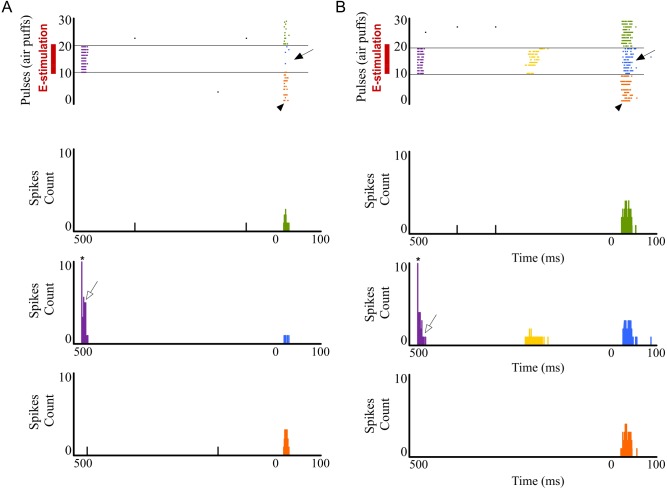
POm E-stimulation before whisker stimulus does not decrease cortical response magnitude and duration when PTX is applied in L1.Raster plots and PSTHs are shown for a supragranular neuron before (A) and after (B) GABAergic inhibitory inactivation in L1. Before PTX application, sensory response (filled arrows) of this example neuron was abolished by POm E-stimulation before whisker stimulus. However, POm E-stimulation did not reduce sensory response when GABAergic inhibitory transmission in L1 was inactivated (B). GABAergic inactivation in L1 allowed POm E-stimulation to cause rebound spikes (in yellow). PTX effect is also shown in the sensory response (arrowheads) enlargement after PTX application. Control condition before (orange) and after (green) POm E-stimulation condition (blue) are shown. POm E-stimulation was applied 500 ms before pulses (air puffs) 11 to 20. Open arrows indicate orthodromic spikes elicited by POm E-stimulation. * indicates stimulation artifacts.